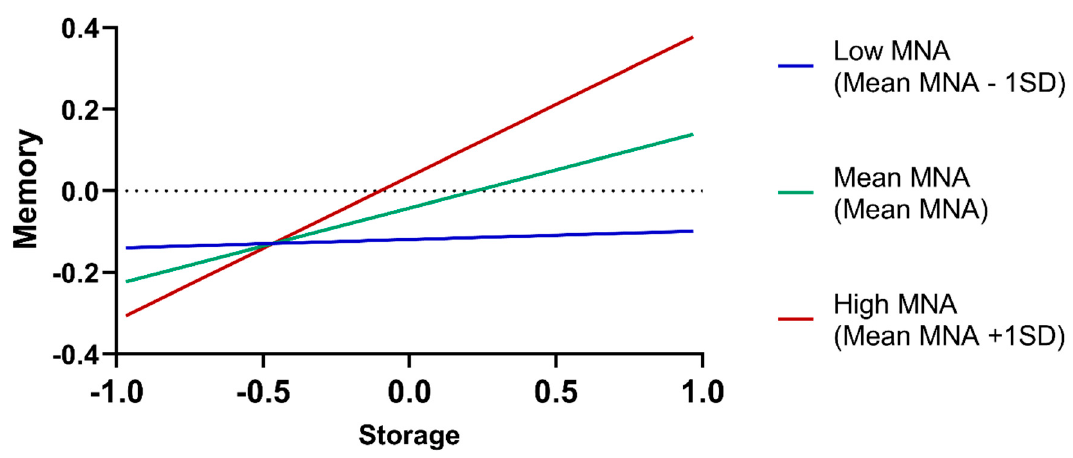
Figure 3. Adjusted association of storage dimension with memory according to nutritional status (mini nutritional assessment, MNA).